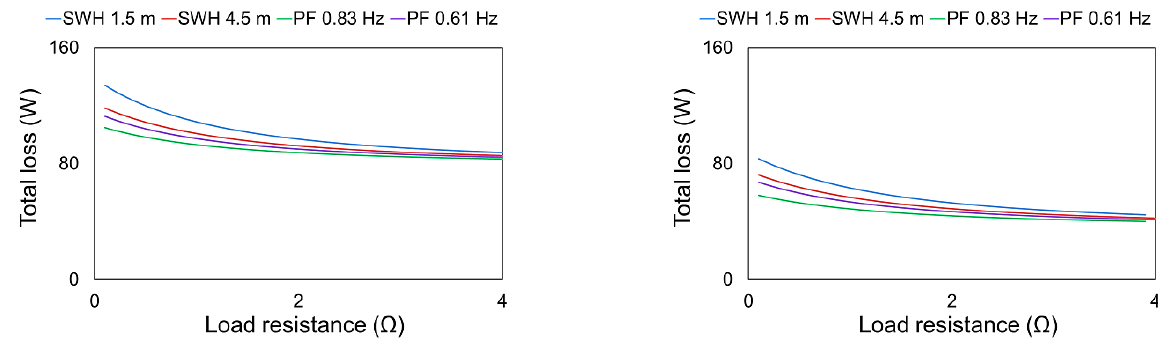
Figure 25. Power loss of iron-cored LPMG ( left ) and semi iron-cored LPMG ( right ) under different random wave parameters and load resistances.